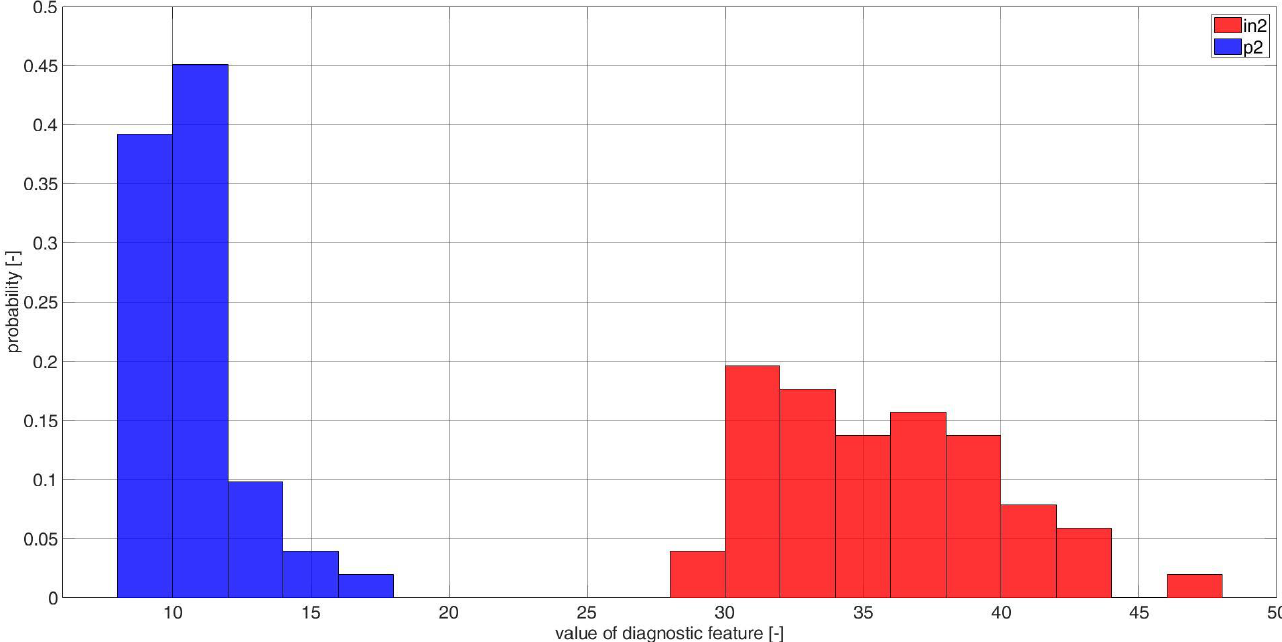
Figure A2. Histograms of diagnostic features based on the CCSM3 (correlation number is 4 — Table A1) bearings in2 and p2.